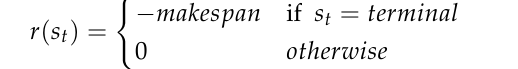
. In this example, the allocation j